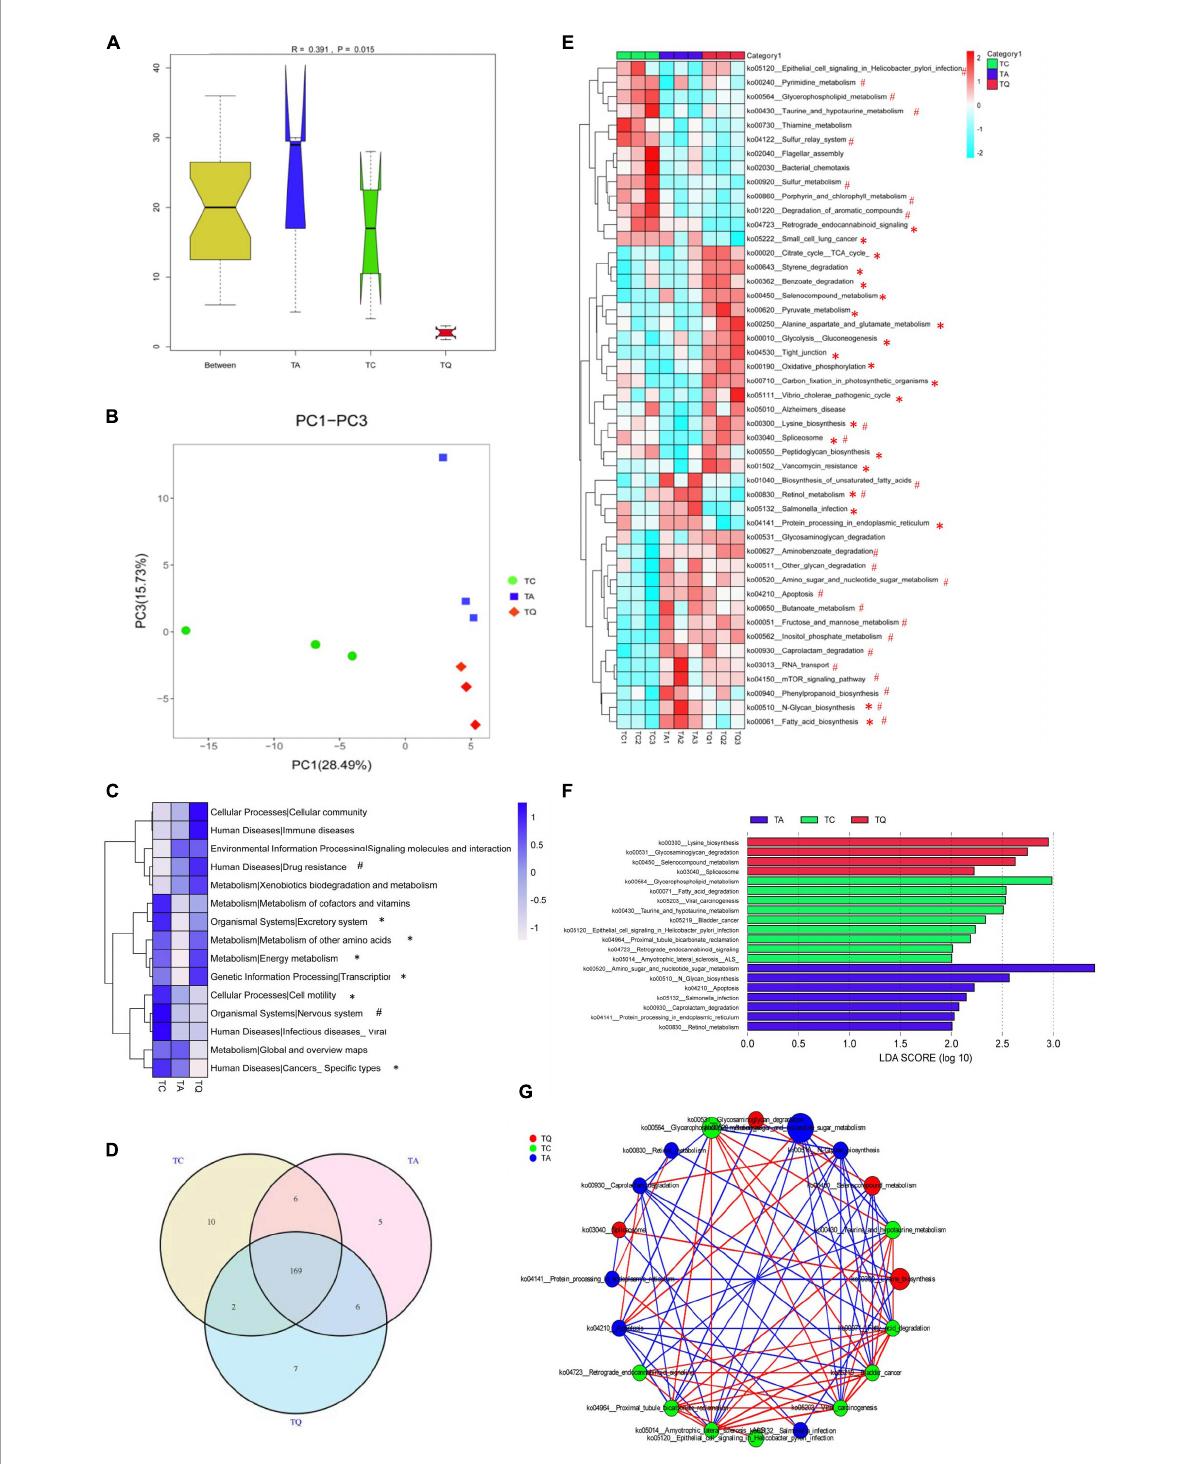
FIGURE3 Metabolic pathway changes of gut microbiota after quercetin treatment. (A) Anosim analysis of KEGG metabolic pathway within groups; (B) Principle coordinate analysis of KEGG metabolic pathway; (C) KEGG level 2 differences within groups, ∗ Significantly different between TA-TQ, # significantly different between TC-TA; (D) Venn diagram of KEGG metabolic pathway within three groups; (E) 47 significantly different pathways within group; ∗ Significantly different between TA-TQ, # significantly different between TC-TA; (F) LDA analysis of 47 significantly different bacteria species; (G) Spearman correlation network analysis of LDA score higher than 4 pathways, different circle size indicate their relative abundance, different color line indicate different correlation, red line indicate positive correlation, blue line indicate negative